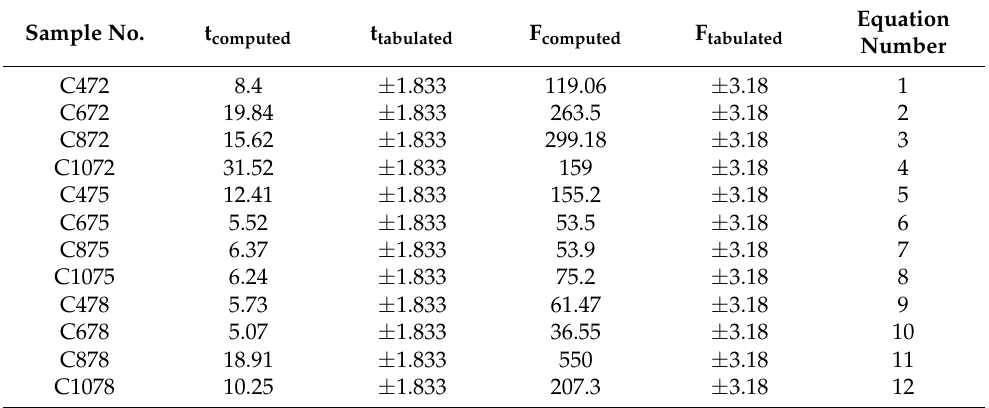
Table 7. Results of t and F tests for the correlation between the UCS and UPV. Sample No. t computed t tabulated F computed F tabulated